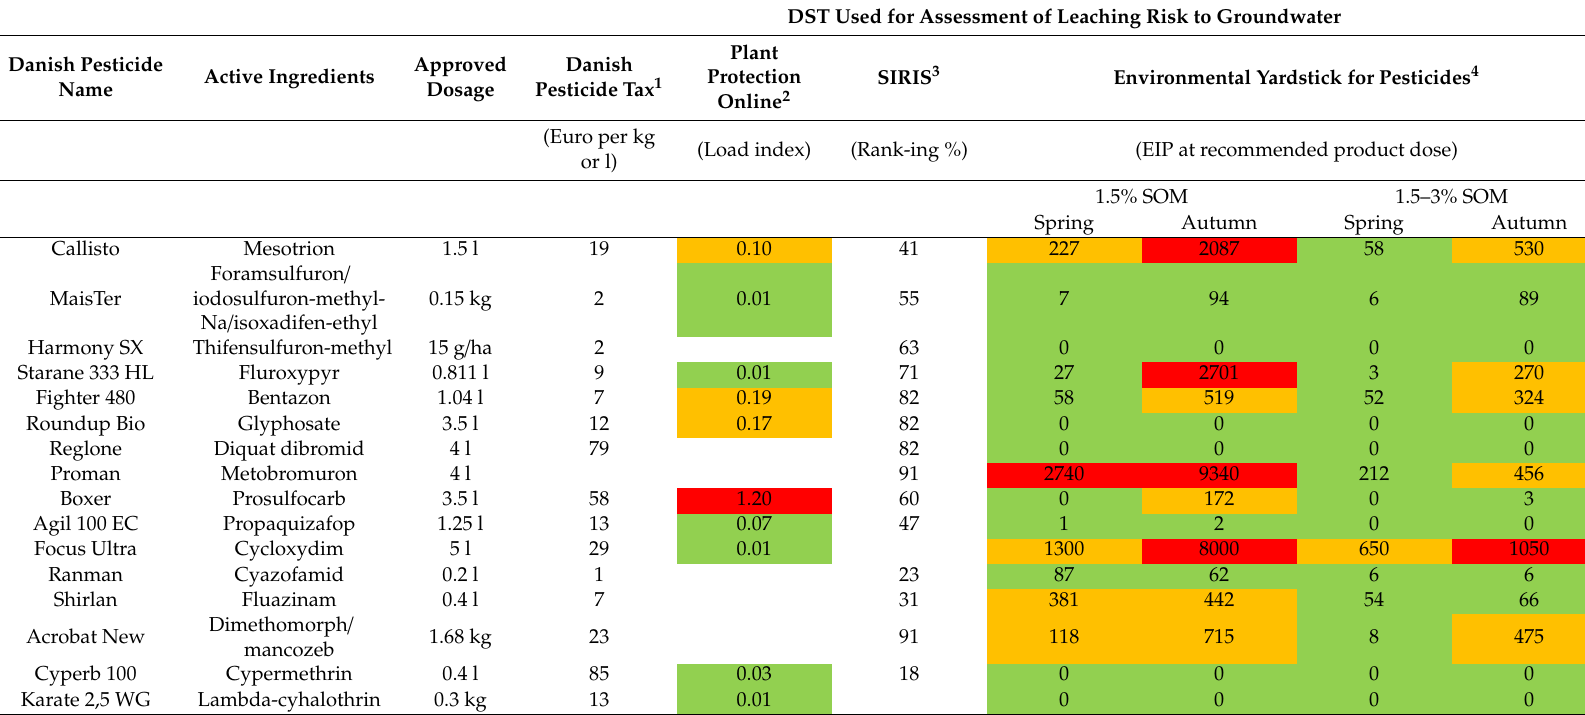
Table 4. Leaching risk profiles for groundwater calculated using SIRIS, Environmental Yardstick for Pesticides and Plant Protection Online for pesticides used on maize and potatoes, in comparison with the Danish pesticide